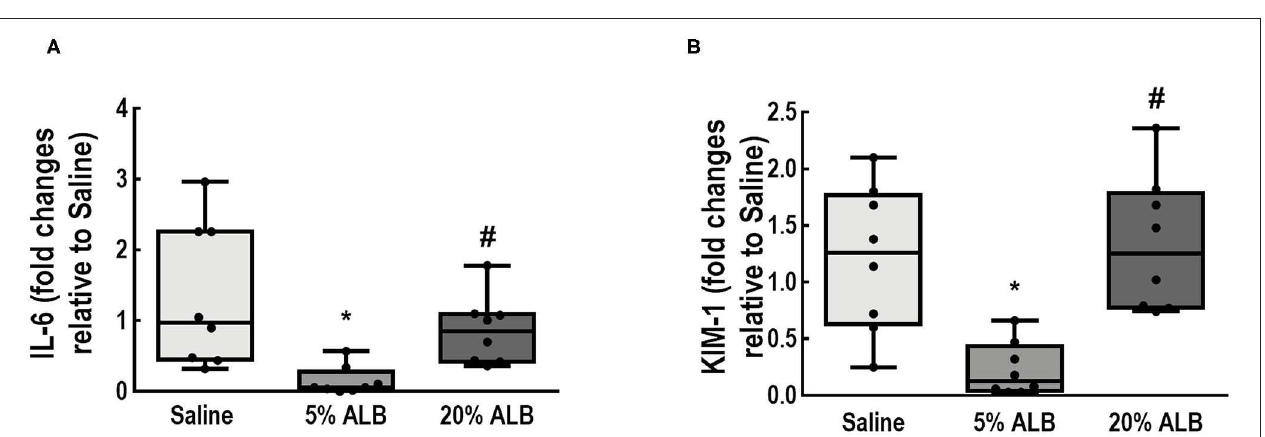
FIGURE 5 | Expression of biologic markers associated with kidney damage. (A) Interleukin (IL)-6 mRNA levels; (B) Kidney injury molecule-1 (KIM-1) mRNA levels. Comparisons among all groups were done using the Kruskal–Wallis test, with significance accepted at p < 0.05. Boxes show the interquartile range (25–75th percentile), while whiskers encompass the range (minimum-maximum) and horizontal lines represent the median in 8 animals/group. Scatter plots are also presented. Relative gene expression was calculated as a ratio of average expression of each gene to the reference gene ( 36B4 ) and expressed as fold change relative to Saline group. * vs. Saline 0.9%; # vs. 5%